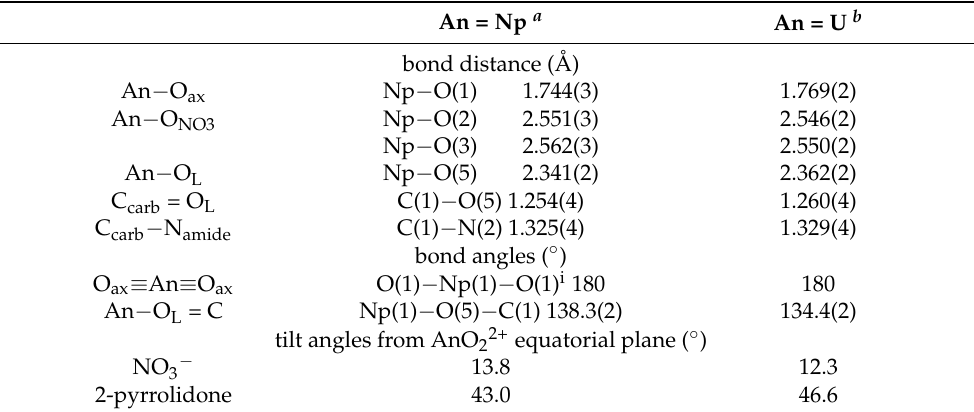
Figure 3. ORTEP view of [NpO 2 (NO 3 ) 2 ( L1 )] n at the 50% probability level. Crystallographic data on [NpO 2 (NO 3 ) 2 ( L1 )] n : CCDC 2208277, C 14 H 22 N 4 Np 1 O 10 , F w = 643.35, 0.22 × 0.09 × 0.04 mm 3 , triclinic, P – 1, a = 6.0172(2) Å , b = 7.6661(2) Å , c = 11.0985(3) Å , α = 75.9330(10)°, β = 84.488(2)°, γ = 76.353(2)°, V = 482.18(2) Å 3 , Z = 1, T = 293 K, D calcd = 2.216 g/cm 3 , μ (Mo K a) = 5.450 mm −1 , GOF = 1.173, R 1 ( I > 2 σ ) = 0.0284, wR 2 (all) = 0.0512.